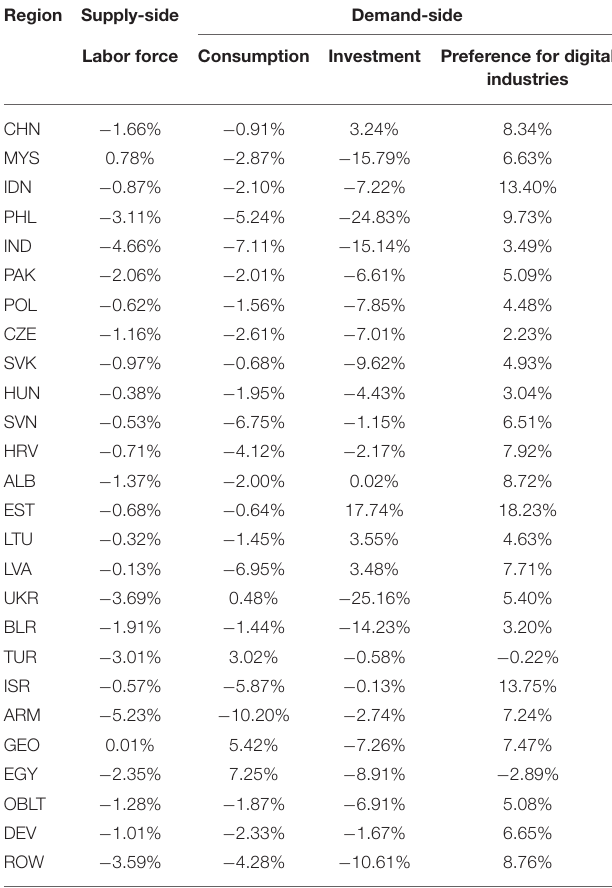
TABLE 7 | Values of supply-side and demand-side shocks in the simulated